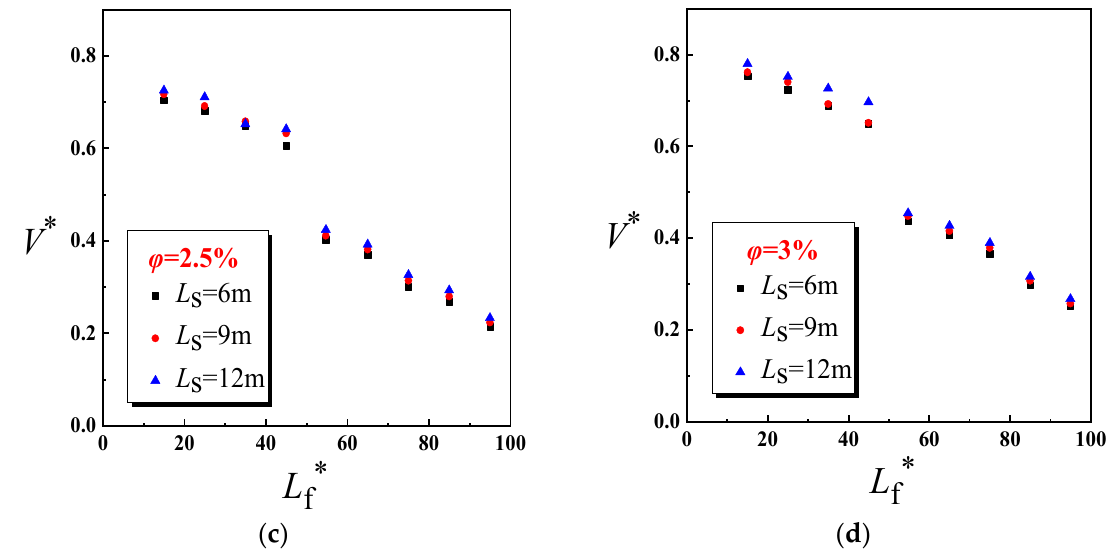
Figure 6. Dimensionless relation between inlet air velocity and fi re source location ( a ) φ = 1.5%, ( b ) φ = 2.0%, ( c ) φ = 2.5%, ( d ) φ = 3.0%. According to Figures 7 and 8, with the increase in L f , the inlet air velocity decreases exponentially. It is worth noting that when the fi re source is located downstream of the shaft, the variation trend of velocity under ϕ = 1.5% is different from others. Through the flow field analysis, it is found that when ϕ = 1.5%, the weak stack effect cannot prevent the backflow, the hot smoke spread to the shaft and been exhausted, the obvious temperature difference and pressure difference inside and outside the shaft drives the longitudinal flow, resulting in a lager inlet air velocity. The subsequent analysis temporarily ignores the conditions when L f ≥ 330 and ϕ = 1.5%.